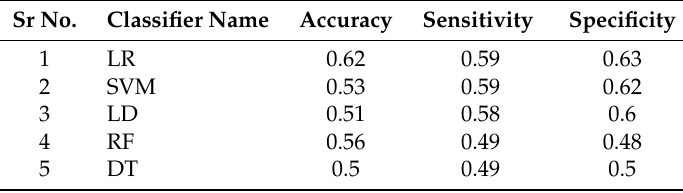
Table 3. 10-Fold Results based on the Top 30 Selected Features based on Proposed 3-Stage Approach. Sr